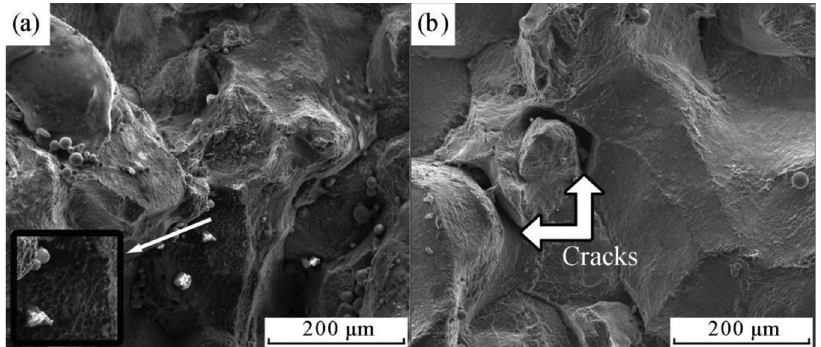
Figure 10: Fractographs of the steel samples A and B at 800°C: (a) steel A and (b) steel